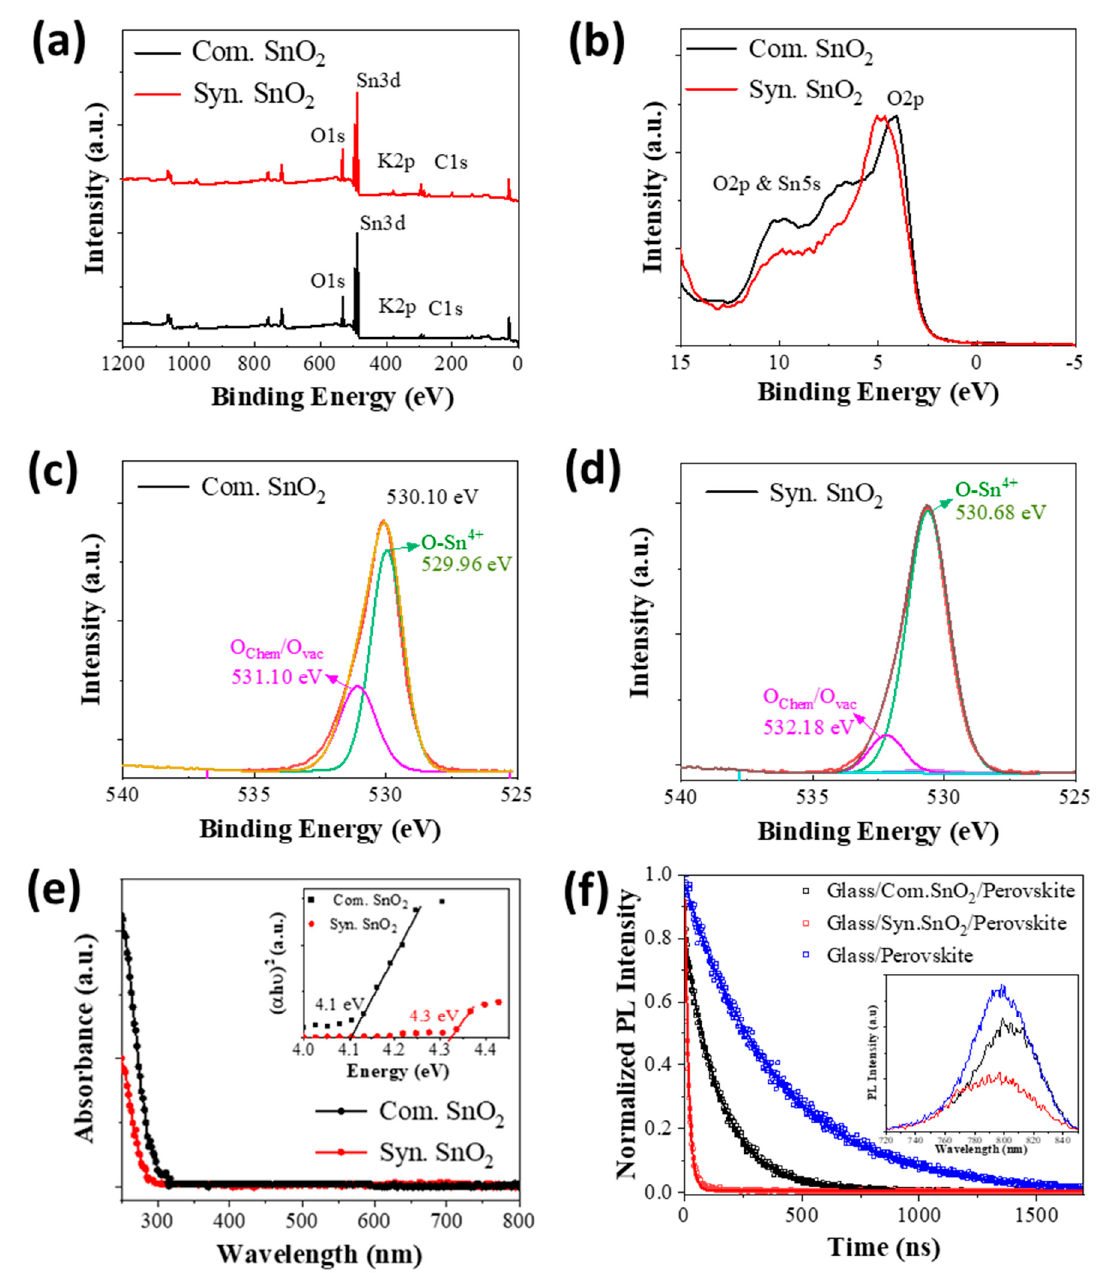
Figure 3. ( a ) XPS survey spectrum of synthesized and commercial SnO 2 films, ( b ) XPS valence spectrum and, high-resolution O1s spectra of ( c ) synthesized and ( d ) commercial SnO 2 nanoparticles, ( e ) UV-visible absorption spectra of SnO 2 films on quartz substrates (inset: corresponding Tauc plots), ( f ) TRPL with fitted exponential decay curves of SnO 2 /perovskite films coated on plain glass (excitation 466 nm, emission 795 nm, excitation and emission from glass side) (inset: corresponding PL emission spectra).